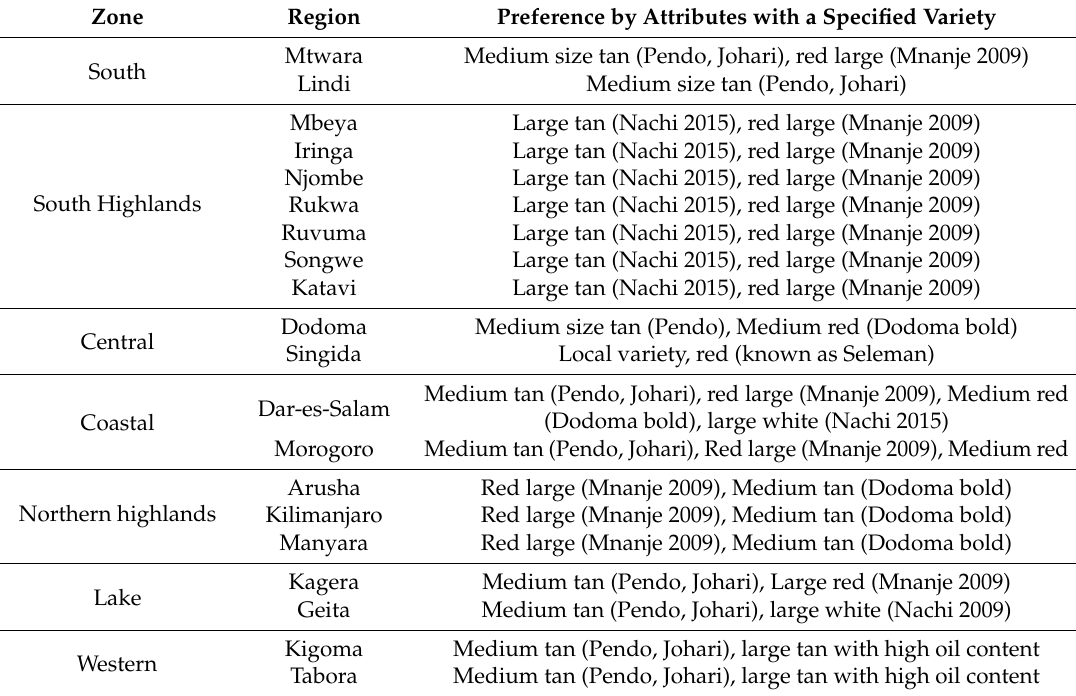
Table 6. Variation of the preferences of groundnut attributes throughout zones and regions ( n = 300). Zone Region Preference by Attributes with a Specified